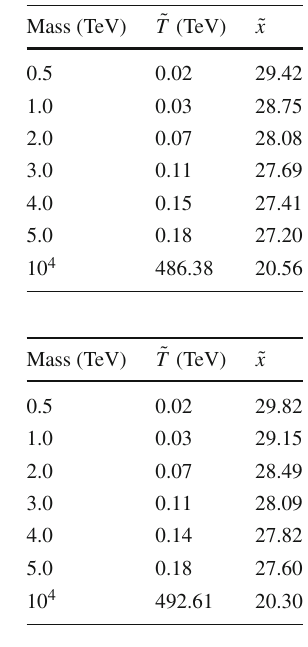
Fig. 6 The relic abundance Y ( x ) for monopole as a function of x = M / T , according to Eq. (13), taking different values of the monopole mass M . Plots in the top and bottom panels: cases of spin-zero and spin-half monopoles,